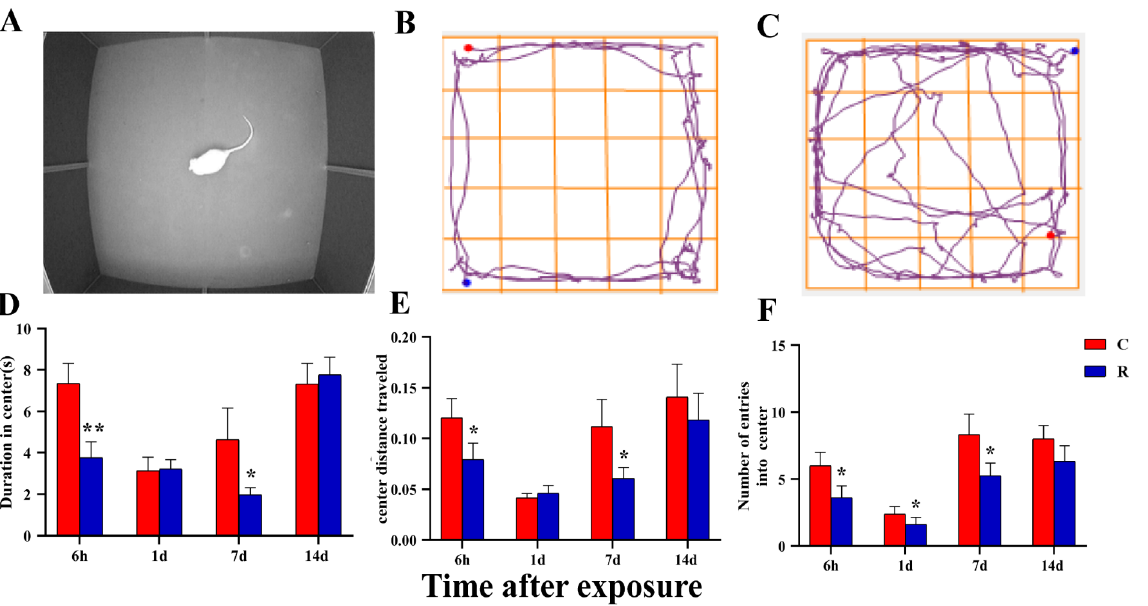
Figure 10. Changes noted during the open fi eld experiment applied to rats after S-band radiation— indicators of exploring behavior. ( A ) The real shot of rats in the non-central area; ( B ) the trajectory diagram of Group R; ( C ) the trajectory diagram of Group C; ( D ) statistical analysis diagram of duration in the central region; ( E ) statistical analysis diagram of the ratio of the moving distance in the central region to the total distance; ( F ) statistical analysis graph of the number of times rats entered the central region. Signi fi cance signs were classi fi ed according to p -value: * p < 0.05 and ** p < 0.01.